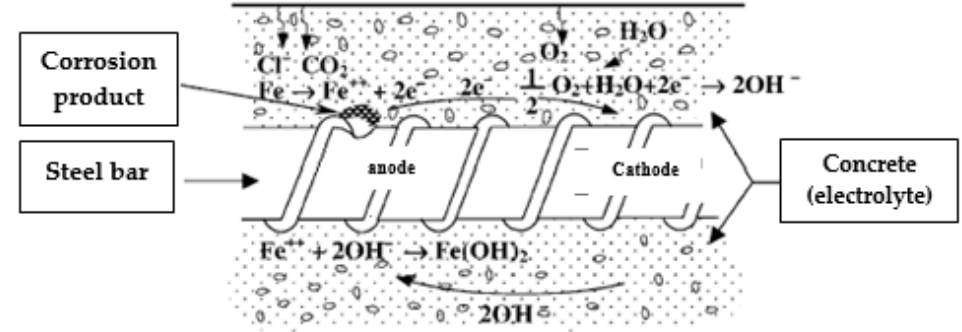
Figure 1. Schematic illustration of corrosion of reinforcement steel in concrete as an electrochemical process.